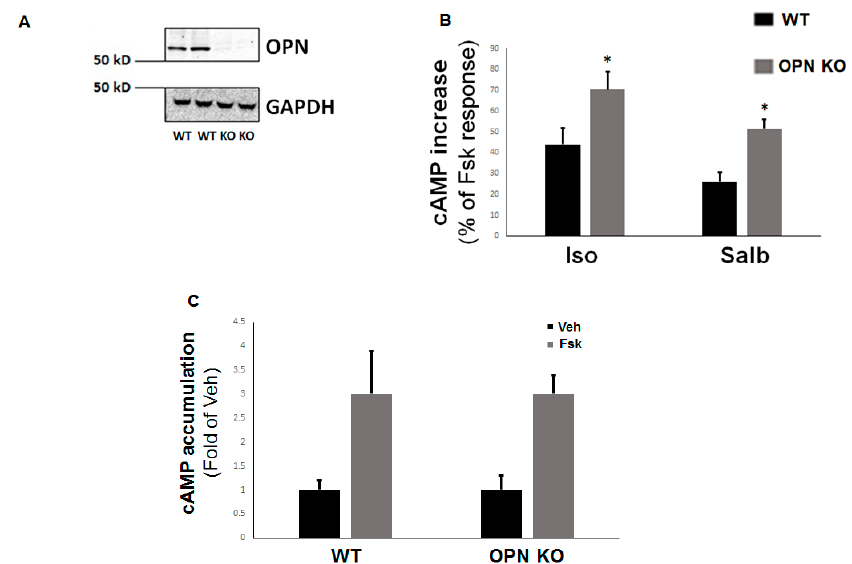
Figure 2. Enhanced β 2 AR-dependent cAMP accumulation in the absence of OPN in H9c2 cardiomyocytes. ( A ) Western blotting to confirm OPN CRISPR-mediated deletion in H9c2 cells infected with OPN-specific CRISPR lentivirus (knockout, KO) or mock CRISPR lentivirus (wild type, WT). Blotting for glyceraldehyde 3-phosphate dehydrogenase (GAPDH) is also shown as loading control. Representative blots from three independent experiments per condition with similar results are shown. ( B ) cAMP accumulation in response to 10 µM isoproterenol (Iso) or 10 µM salbutamol (Salb) in control WT and in OPN-depleted (OPN KO) H9c2 cells, expressed as percent of the respective cAMP production induced by 10 µM forskolin (Fsk). *, p < 0.05, vs. WT; n = 3 independent experiments/condition/cell clone. ( C ) cAMP accumulation in response to 10 µM forskolin (Fsk) or vehicle (Veh) in control WT and in OPN-depleted (OPN KO) H9c2 cells. No significant differences were observed between WT-Fsk and OPN KO-Fsk at p = 0.05 (n = 3 independent experiments/condition/cell clone).